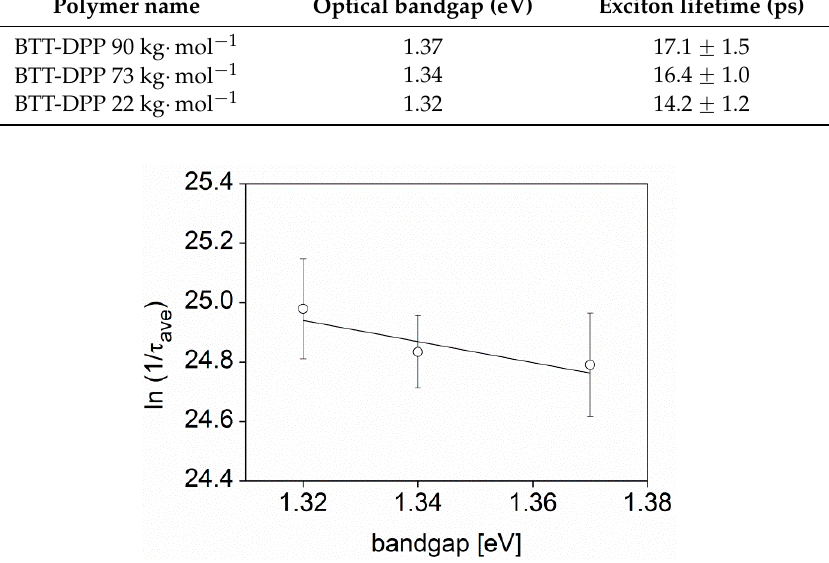
Figure 3. The natural logarithm of the rate of singlet exciton decay plotted as a function of optical bandgap for three BTT-DPP polymers with different molecular weight and film crystallinity. The open circles represent the experimentally determined rates of exciton decay of polymer films studied herein, estimated using ultrafast transient absorption spectroscopy. The error bars represent the square root of the mean residual variance of the exciton lifetime as received from the exponential fits of the exciton decays. The black line is the best fit straight line to all data points showing a negative slope with a value of − 3.5 ± 1.9 eV − 1 .